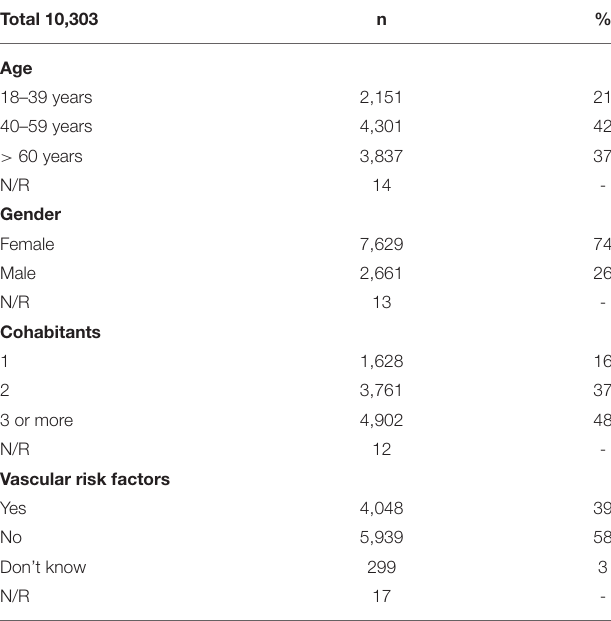
TABLE 1 | Demographic data and presence of vascular risk factors. TABLE 2 | Adherence to medical controls, perception of safety measures of health institutions and behavior of population regarding stroke